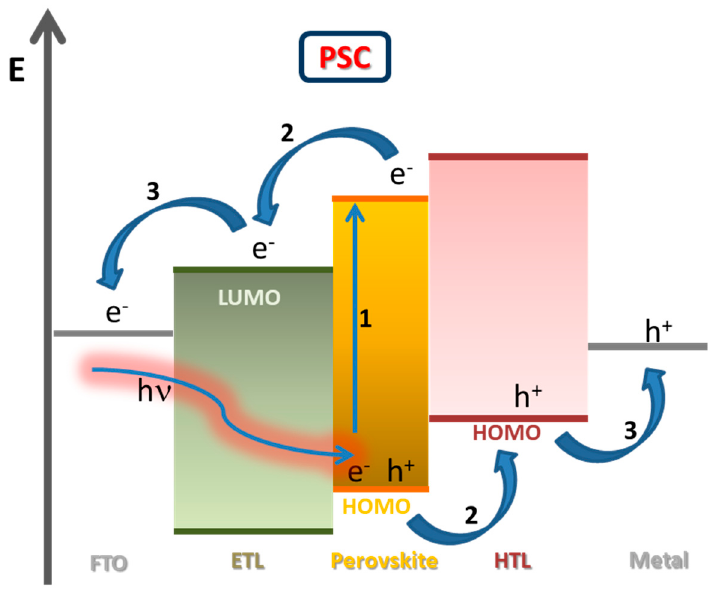
Figure 12. Band diagram and main processes and PSC: (1) Absorption of photon and free charges generation; (2) Charge transport; (3) Charge extraction.